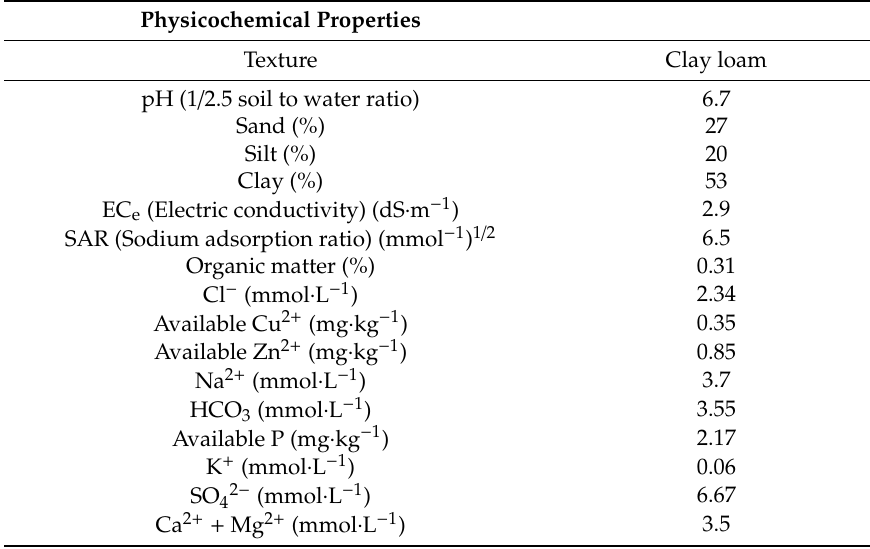
Table 1. Physiochemical Properties of soil for